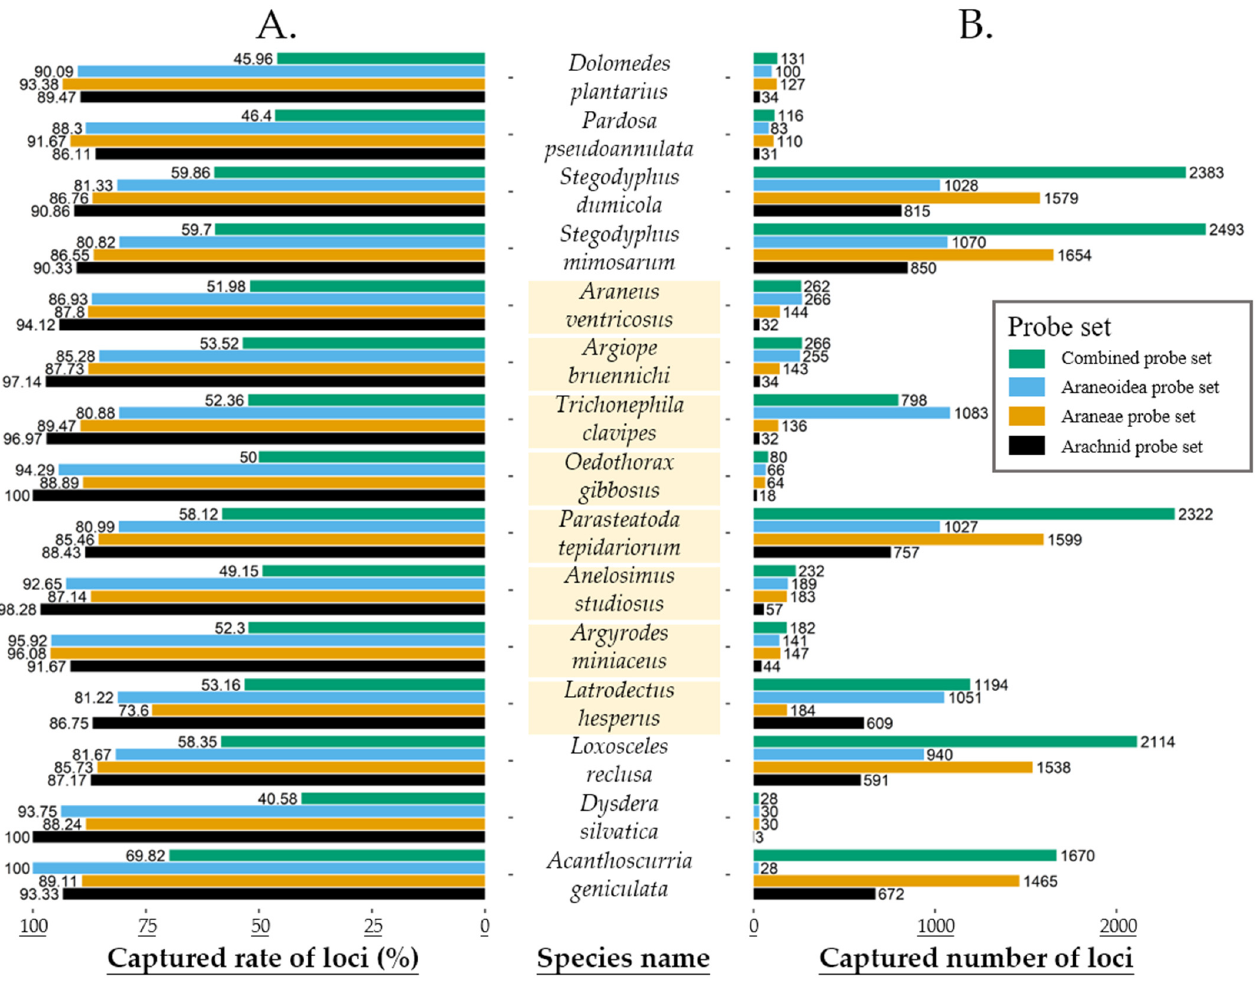
Figure 1. Results of in silico tests. Capture rate of loci ( A ) and captured loci number ( B ) in each probe set. The Araneoidea species are shaded in orange. Table 2. List of the genomes for probe-set design and the numbers of captured loci. All probe sets used in this research are listed below, ordered by published year. This table displays the targeted taxa of probe-set design, species names of the genomes used to identify UCE loci, species names of the genomes used to design probes, number of UCE loci, number of probes, and the published year of the probe set.